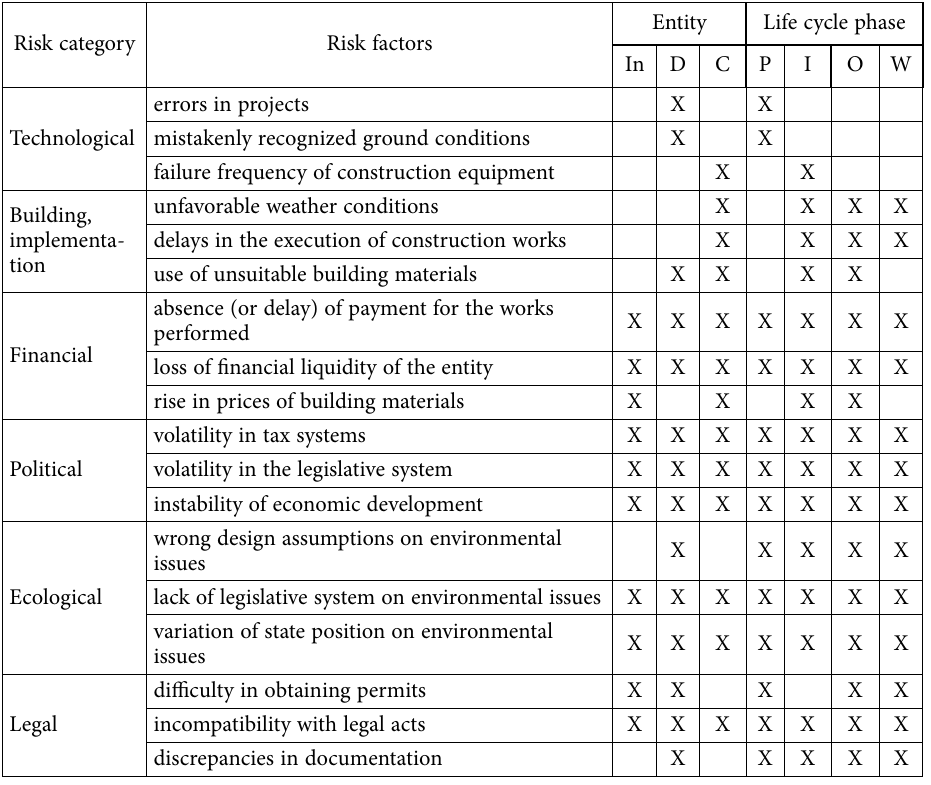
Table 1. Division of risk factors by category and the entity directly related to them for residential build- ings and service facilities (source: own study based on Zhi, 1995; N. A. Kartam & S. A. Kartam, 2001; Wiguna & Scott, 2006; Shevchenko, Ustinovichius, & Andruškevičius, 2008; Ilg, Scope, Muench, & Guenther, 2017; Oduyemi, Okoroh, & Fajana, 2016; Yuting & Carmichael, 2018) Risk